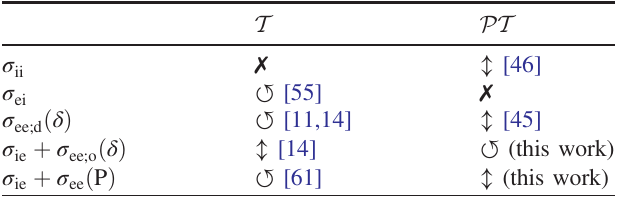
TABLE II. Classification of the photocurrent conductivity in the T -/ PT -symmetric systems. The symbols ↕ and ↺ denote photocurrents induced by linearly polarized and circularly po- larized light, respectively. The photocurrent denoted by “ (this work) ” is clarified in our current paper. The symbols d and o in the term σ represent the diagonal and off-diagonal components ee in Eq. (28), while (P) and ( δ ) denote the of the velocity matrix v μ ab terms consisting of the principal integration (reactive part) and delta function (absorptive part),